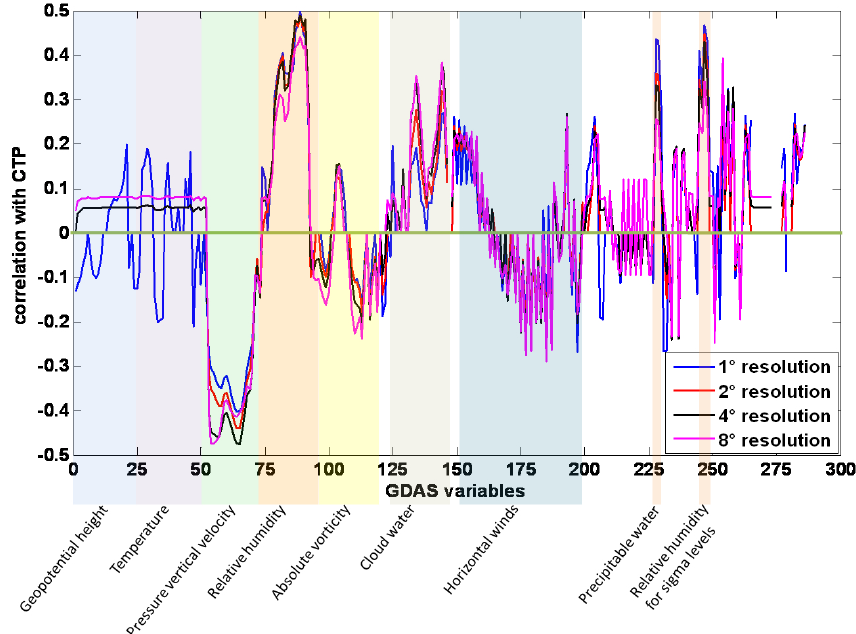
Fig. 8. Correlations between MODIS cloud top pressure and the GDAS assimilation outputs for 4 model spatial resolutions: blue 1 ◦ , red 2 ◦ , black 4 ◦ and magenta 8 ◦ . The zero correlation data points are the variables that did not pass the p-value < 0.01 test.